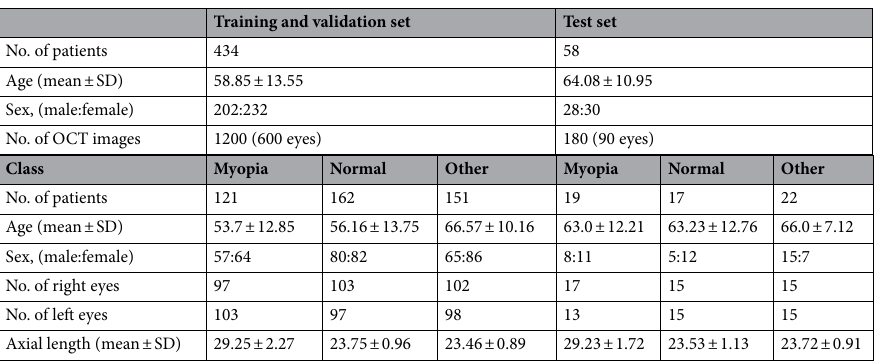
Table 1. Summary of the demographics of training, validation, and test data sets. Class myopia included eyes with axial length of 26.5 mm or more. Class normal and other included eyes with axial length between 21.5 mm and 26.0 mm.